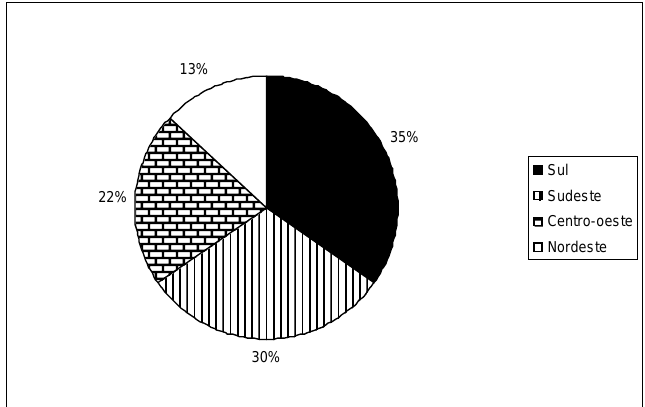
Figura 3. Distribuição dos grupos de pesquisa por região brasileira.